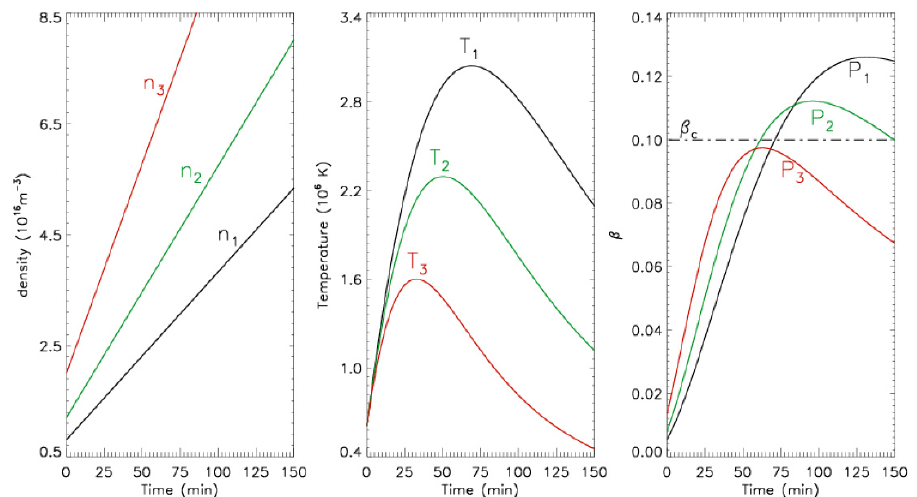
Figure 3. The temporal evolution of the plasma density (left), temperature (middle) and 𝛽 value (right) with different initial density at the same height H = 3 × 10 (cid:2875) m. The initial density 𝑛(𝐻) = 0.8 × 10 (cid:2869)(cid:2874) 𝑚 (cid:2879)(cid:2871) (black), 1.2 × 10 (cid:2869)(cid:2874) 𝑚 (cid:2879)(cid:2871) (blue) and 2.0 × 10 (cid:2869)(cid:2874) 𝑚 (cid:2879)(cid:2871) (red), respectively. We also adopt the model of magnetic field of Dulk and McLean [25] to derive the magnetic field (about 56 Gauss), magnetic scale length ( 𝐿 (cid:3003) ), and the starting energy (52.3 eV) of the upward energetic parti- cles.